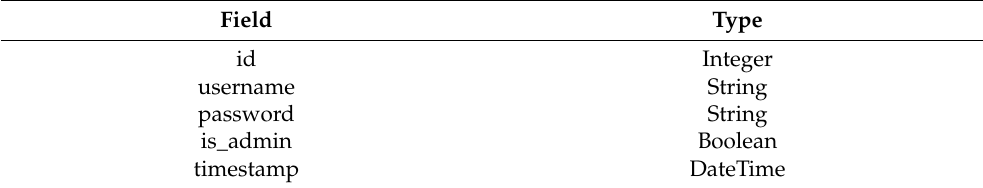
Table A6. Fields and their types for the User table in the database.